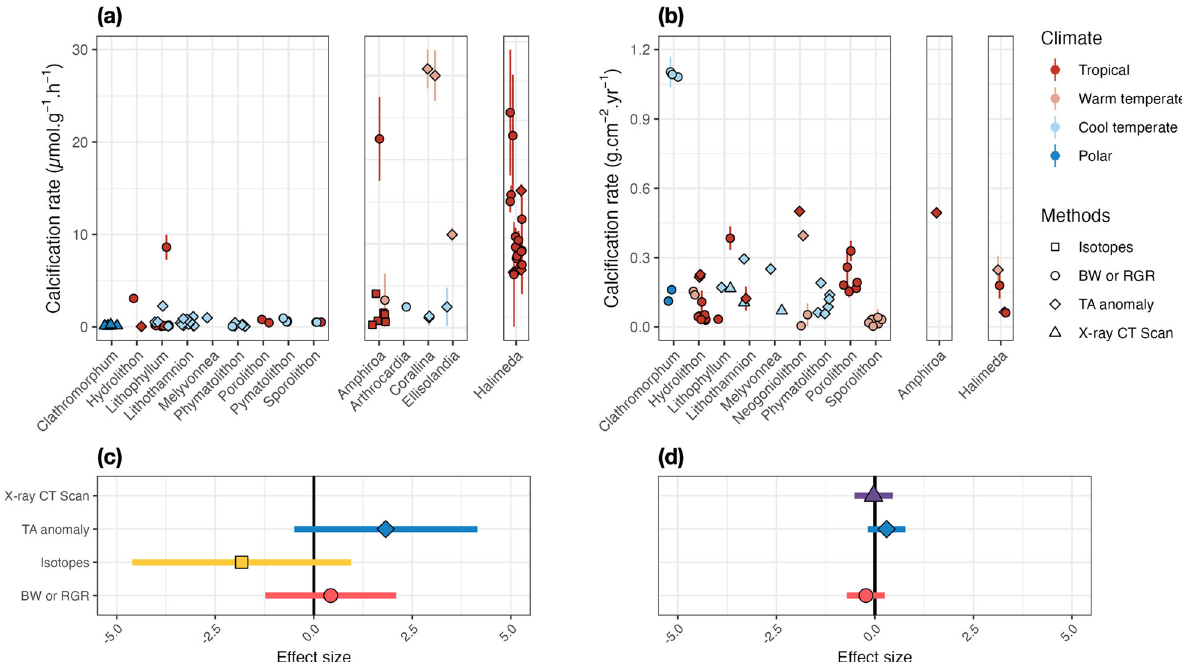
Fig. 7 Comparison of methods to measure calci fi cation rate in individual CCA. We apply a general linear mixed model (GLMM) to our meta-analysis data to examine the in fl uence of measurement method on calci fi cation rate measurements, while accounting for the in fl uence of genus and climate zone (Calci fi cation rate | Methods ~ Genus + Climate zone). a , b Calci fi cation rates from all genera of CCA in our meta-analysis with measurement methods and climate zone shown. Smaller panels denote articulate coralline algae and Halimeda spp. c [biomass normalised rates] and d [surface area-normalised rates] demonstrate the in fl uence of the measurement method on the reported calci fi cation rate determined from the GLMM model. In the key, BW refers to Buoyant Weight, RGR to Relative Growth Rate, and CT to Computed